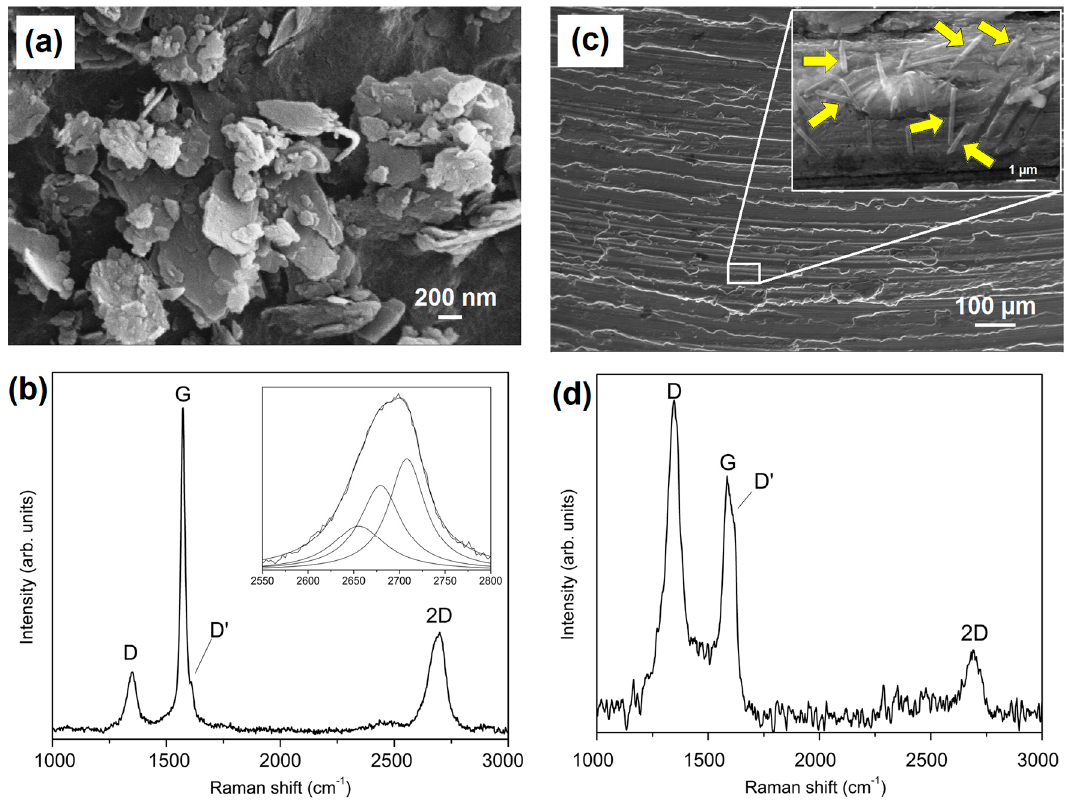
Figure 2. ( a ) SEM image and ( b ) Raman spectrum of the as-received GNSs. The inset in ( b ) shows the fit of the 2D peak by three Lorentzian functions; ( c ) SEM image and ( d ) Raman spectrum of the surface of the GNS/AA1050 composite obtained via FSP at 1800 rpm and 63 mm/min advancing speed. The inset in ( c ) shows the detail of the dispersion of the GNSs on the surface.